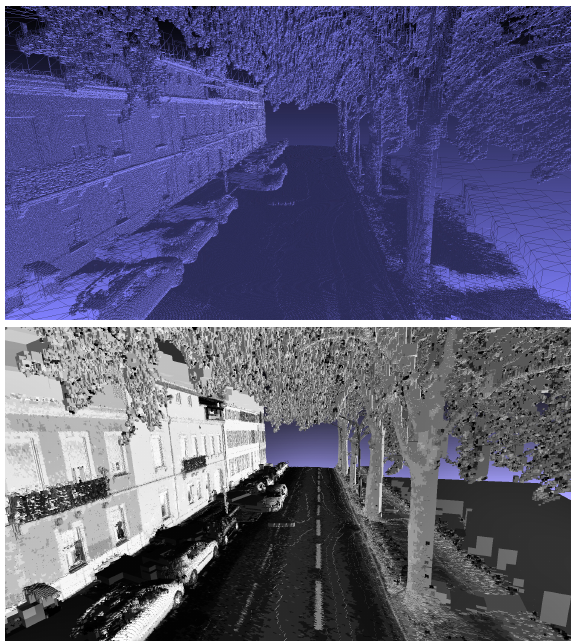
Figure 1: Result of the proposed methods : first the resulting surface, then textured with the regularized reflectance of the data.